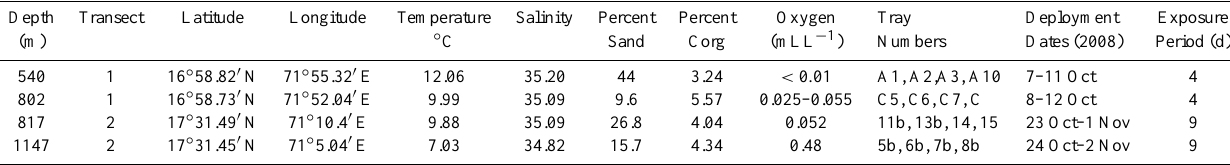
Table 1. Depth, location, physical characteristics and colonization tray deployment information for experiments conducted on the W. Indian margin. Temperature, salinity and % POC data are taken from Hunter et al. (2012); these authors made measurements at identical study sites at the same